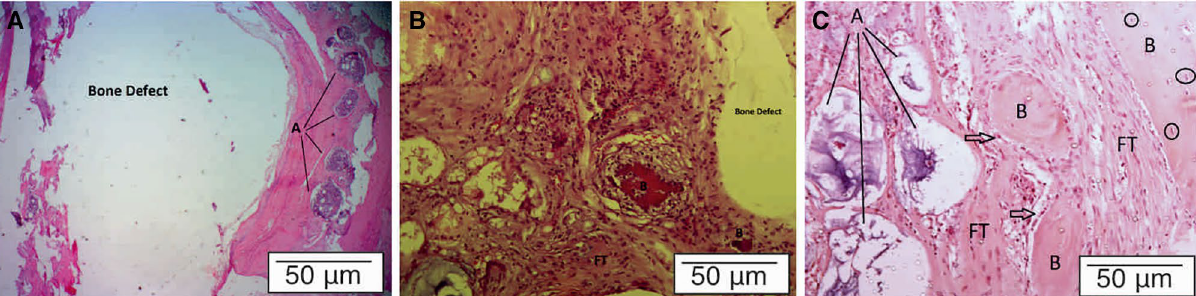
Figure 10. Histology of samples. ( A) Critical-sized bone defects without treatment: A bone defect was identified in the central part of the section. Around the bone defect, matured bone containing the bone marrow ( A ) was detectable. ( B) Critical-sized bone defects filled with hydrogel without PEEK (ADCNCs/SF): The major area of bone defects were filled with connective and fibrous tissue (FT). Bone spicules with central mineralization were observed in some parts ( B ). ( C) Critical-sized bone defects filled with a hydrogel containing PEEK (ADCNCs/SF/PEEK): Various microcystic areas containing the primary phase of calcification ( A ) and several islands of new bone formation ( B ) were present in the healing area. The black arrows show osteoblasts around the bone spicules. The cavity was filled with regenerative tissue, including fibrous tissue (FT) and bone matrix. Matured bone containing osteoblasts (black circles) is obvious at the section’s right